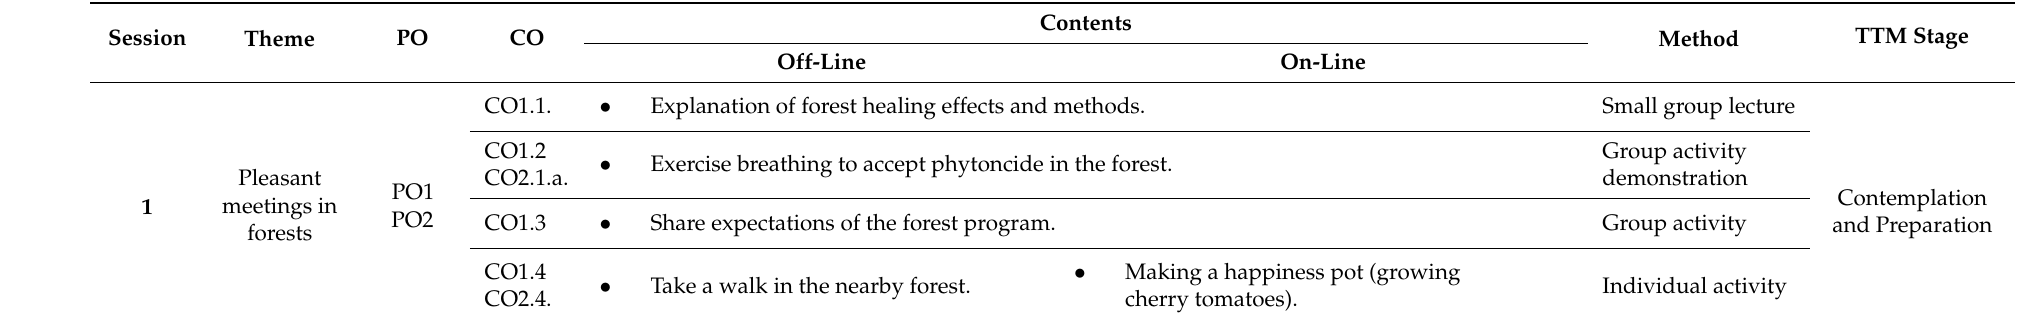
Table 5. Details Regarding the Composition of Each